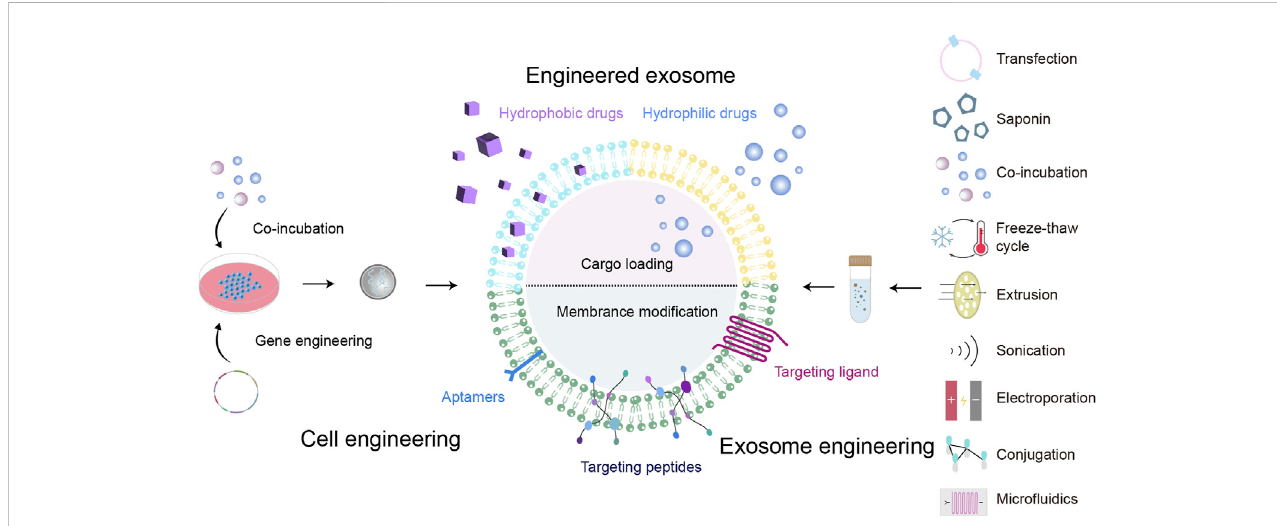
FIGURE 3 Diagram of engineered exosome. The engineering strategies of exosomes include cell engineering and exosome engineering. Hydrophobic drugs, hydrophilic drugs and targeted ligands can be loaded onto exosomes through different methods.